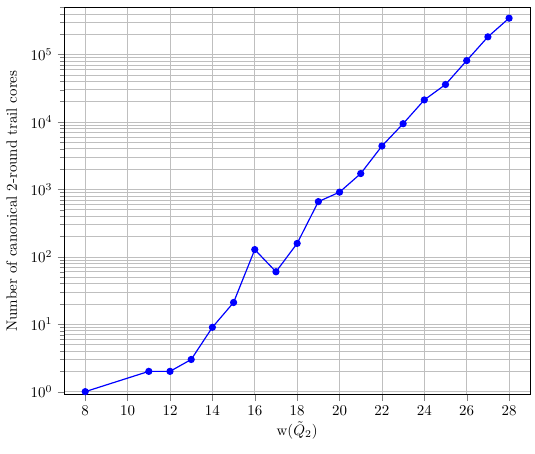
Figure 4: The number of canonical 2-round trail cores in Subterranean up to weight